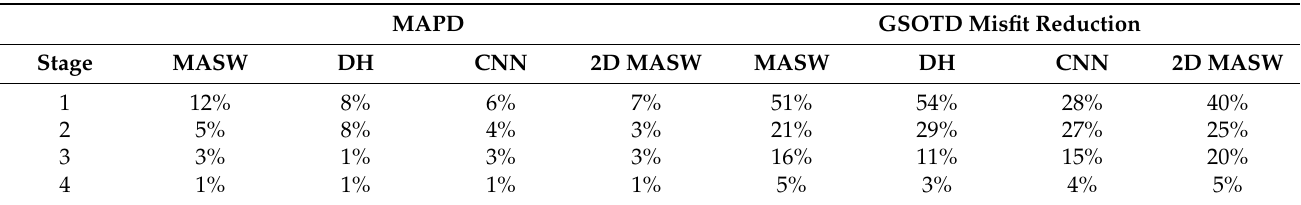
Figure 9. The updated 2D V S images from the MASW starting model at the end of FWI Stages: ( a ) 1, ( c ) 2, ( e ) 3, and ( g ) 4. The percent deviation of the 2D V S images relative to the 2D V S image from the prior stage are shown for Stages: ( b ) 1, ( d ) 2, ( f ) 3, and ( h ) 4. The overall mean absolute percent difference (MAPD) values for each updated 2D V S image relative to the initial image at the beginning of each stage are also indicated. Table 1. Mean absolute percent difference (MAPD) and graph space optimal transport distance (GSOTD) misfit reduction values in terms of percentage for all four starting models across all four stages of the